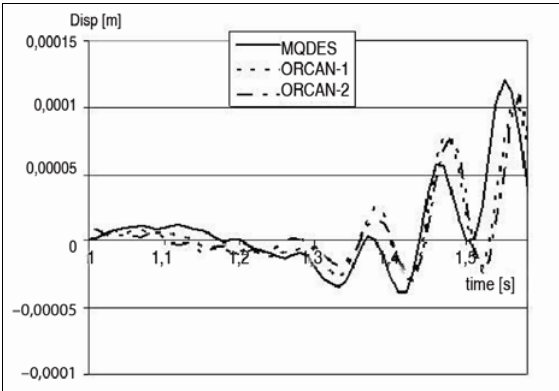
Fig 8 . Displacements diagram of the top of the segment in